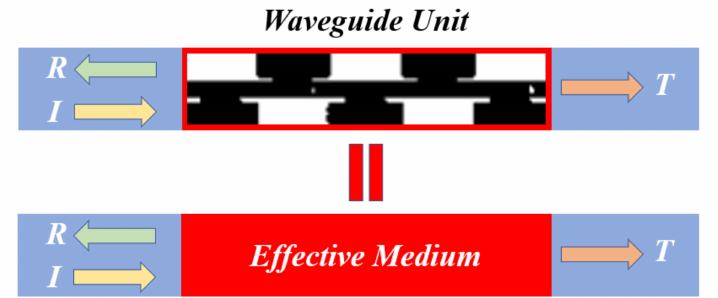
Figure A1. Schematic diagram of the effective medium